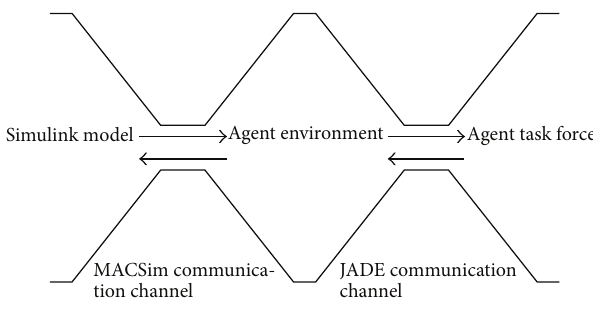
Figure 9: A complete model of